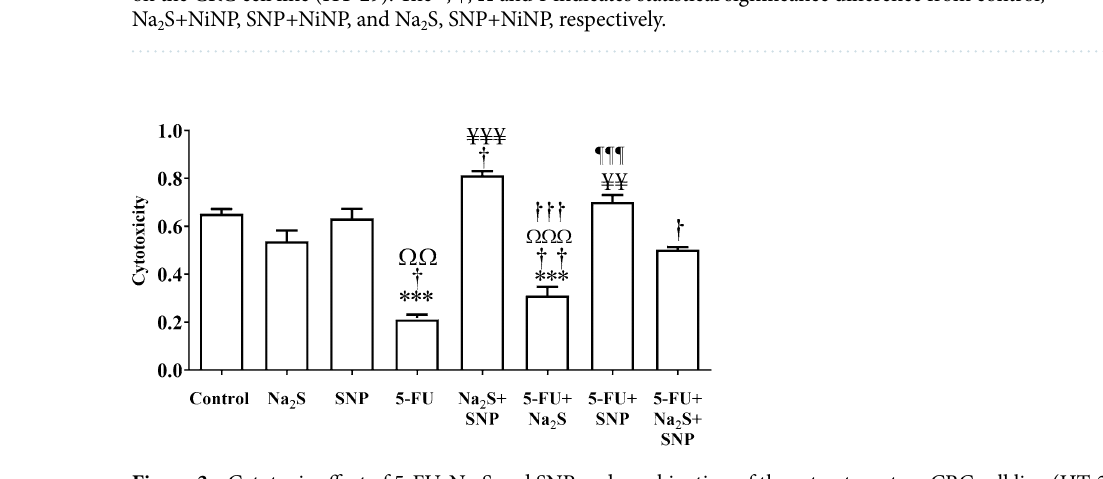
Figure 2. Cytotoxic effect of NiNPs on CRC cell line. The cell viability after treatment with NiNP for 24hrs on the CRC cell line (HT-29). The *, †, Ω and ¥ indicates statistical significance difference from control,